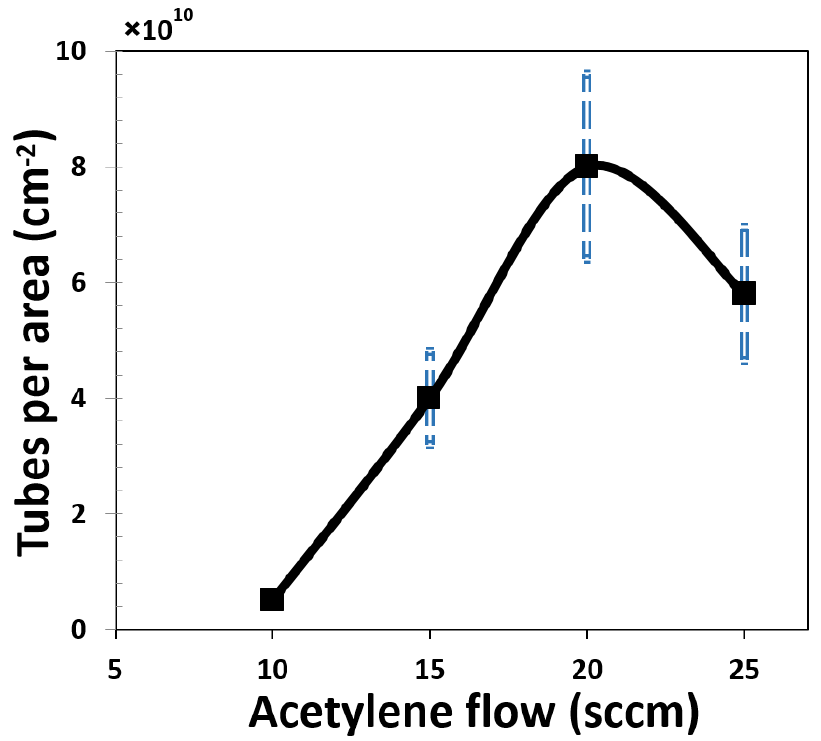
Figure 3. Number of fibers per area as function of acetylene flow.